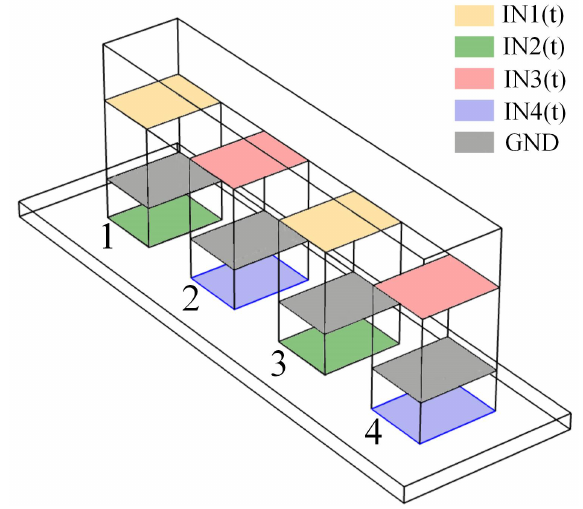
Figure 8. The distribution of input excitation.